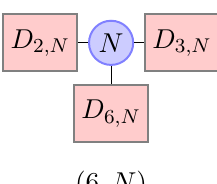
Figure 5 . As a final generalization of the (3 , 2) theory we may considering a diagonal exactly marginal SU( N ) gauging of a D 2 (SU( N )) := D 2 ,N theory, a D 3 (SU( N )) := D 3 ,N SCFT, and a D 6 (SU( N )) := D 6 ,N theory. Here gcd(6 , N ) = 1